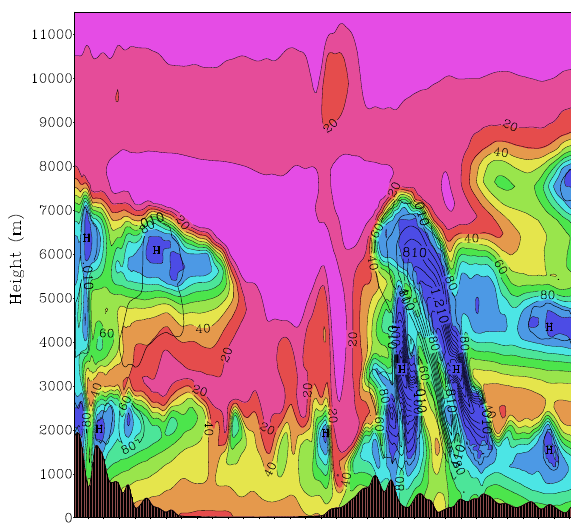
Fig. 12. Saturated equivalent potential temperature θ e (color) and pseudo angular momentum M = v + fx (thick contours) at 09:00 UTC on section x2 of Fig. 3 (contour interval 10 m s − 1 , arbitrary origin).